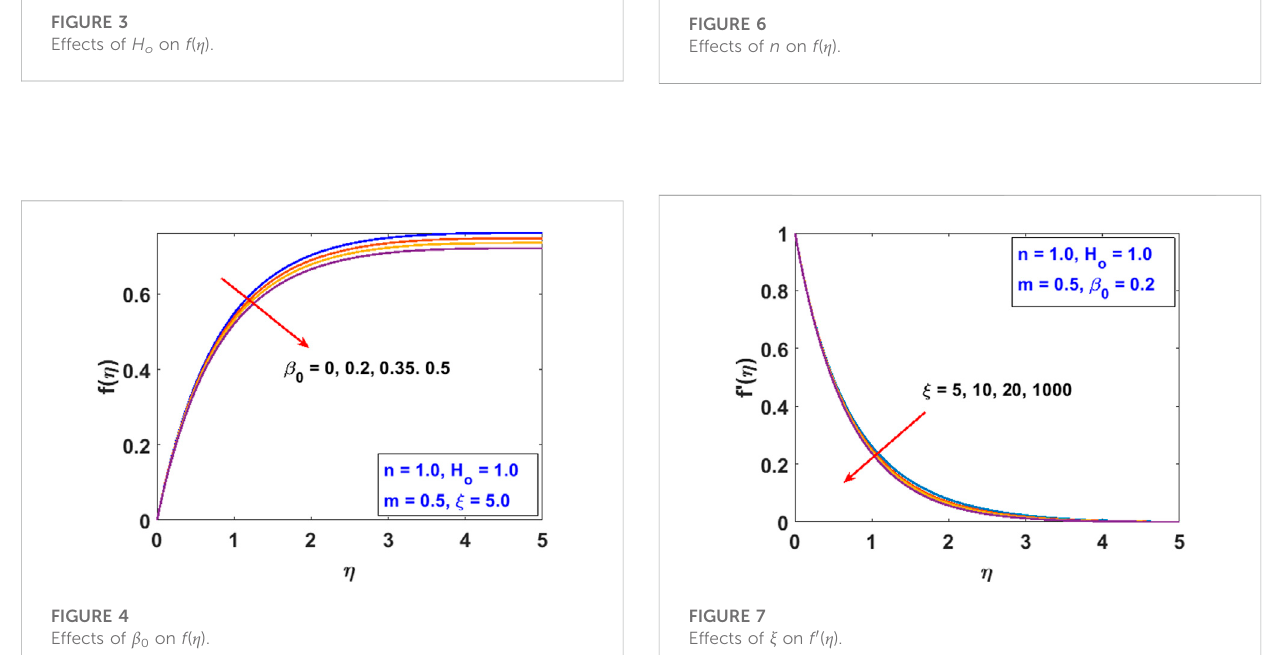
FIGURE 3 Effects of H o on f ( η ).